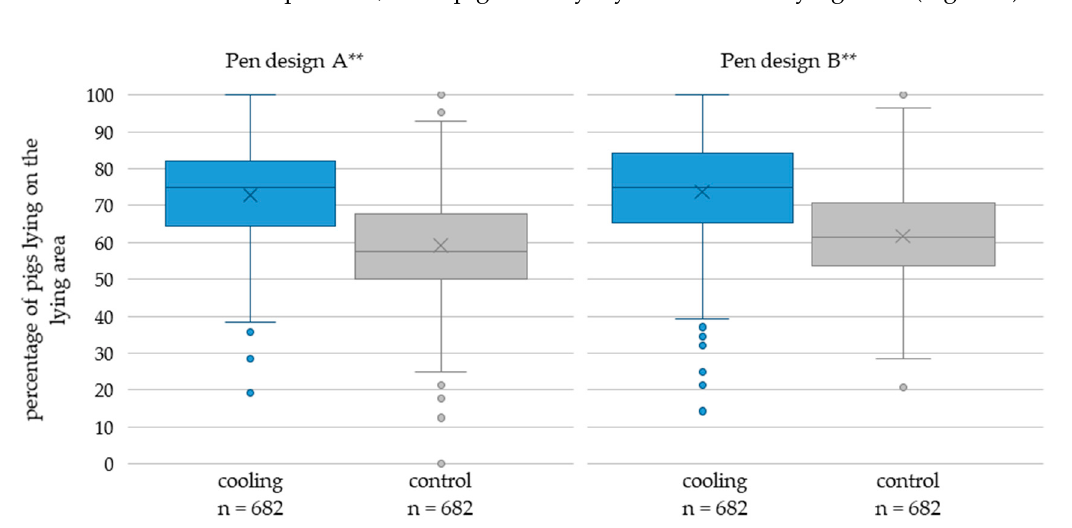
Figure 6. Effect of the floor cooling on percentage of pigs (relative to total number of lying pigs) lying on the solid lying area for pen design A (73% vs. 59%; SED 2.9; p = 0.002) and B (74% vs. 62%; SED 2.9; p = 0.0098) (* = significant effect with ** < 0.01; n = number of observations, usually 114 per and period, each boxplot contains data of two pens).